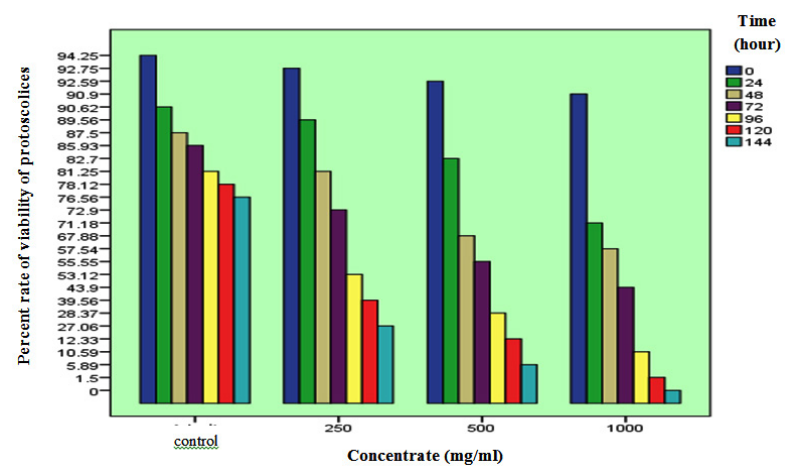
Fig. 6. Effect of the crude alcoholic extracts of Spirogyra sp . (1000,500,250) mg / ml in the viability of the protoscolices table 4. The percentage of the viability of the protoscolices after exposure to different concentrations of the crude alcohol extract of Spirugera sp . and for different time periods in vitro Time(hour) Percentage rate of protoscolices, standard